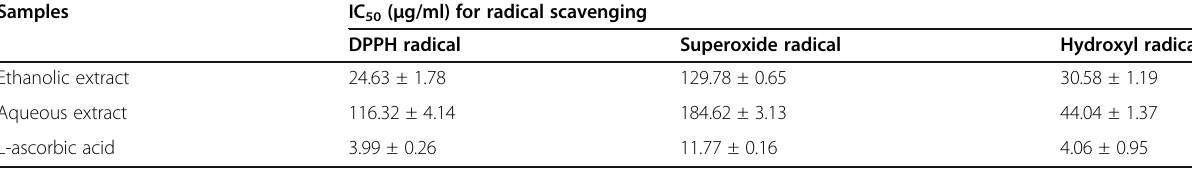
Table 2 In vitro antioxidant properties of L-ascorbic acid (a positive control), aqueous and ethanolic extracts of S. exigua roots